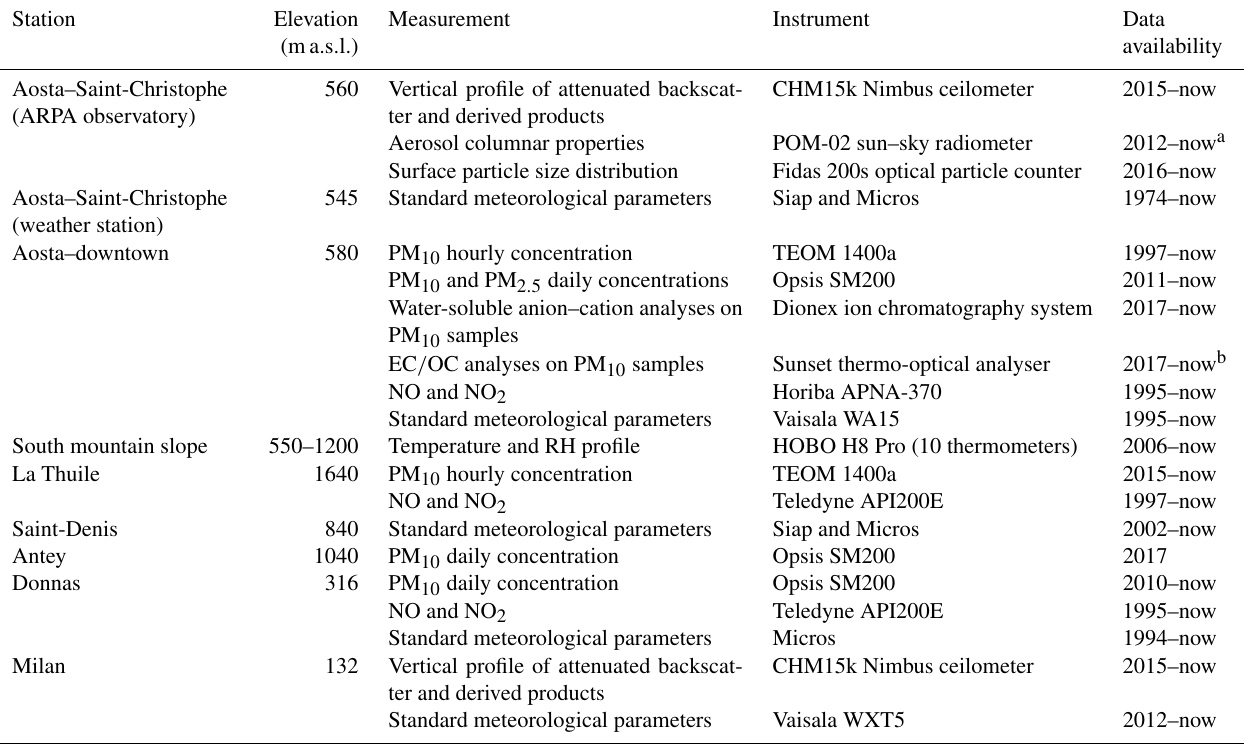
Table 1. Observation sites, measurements, and instruments employed in this